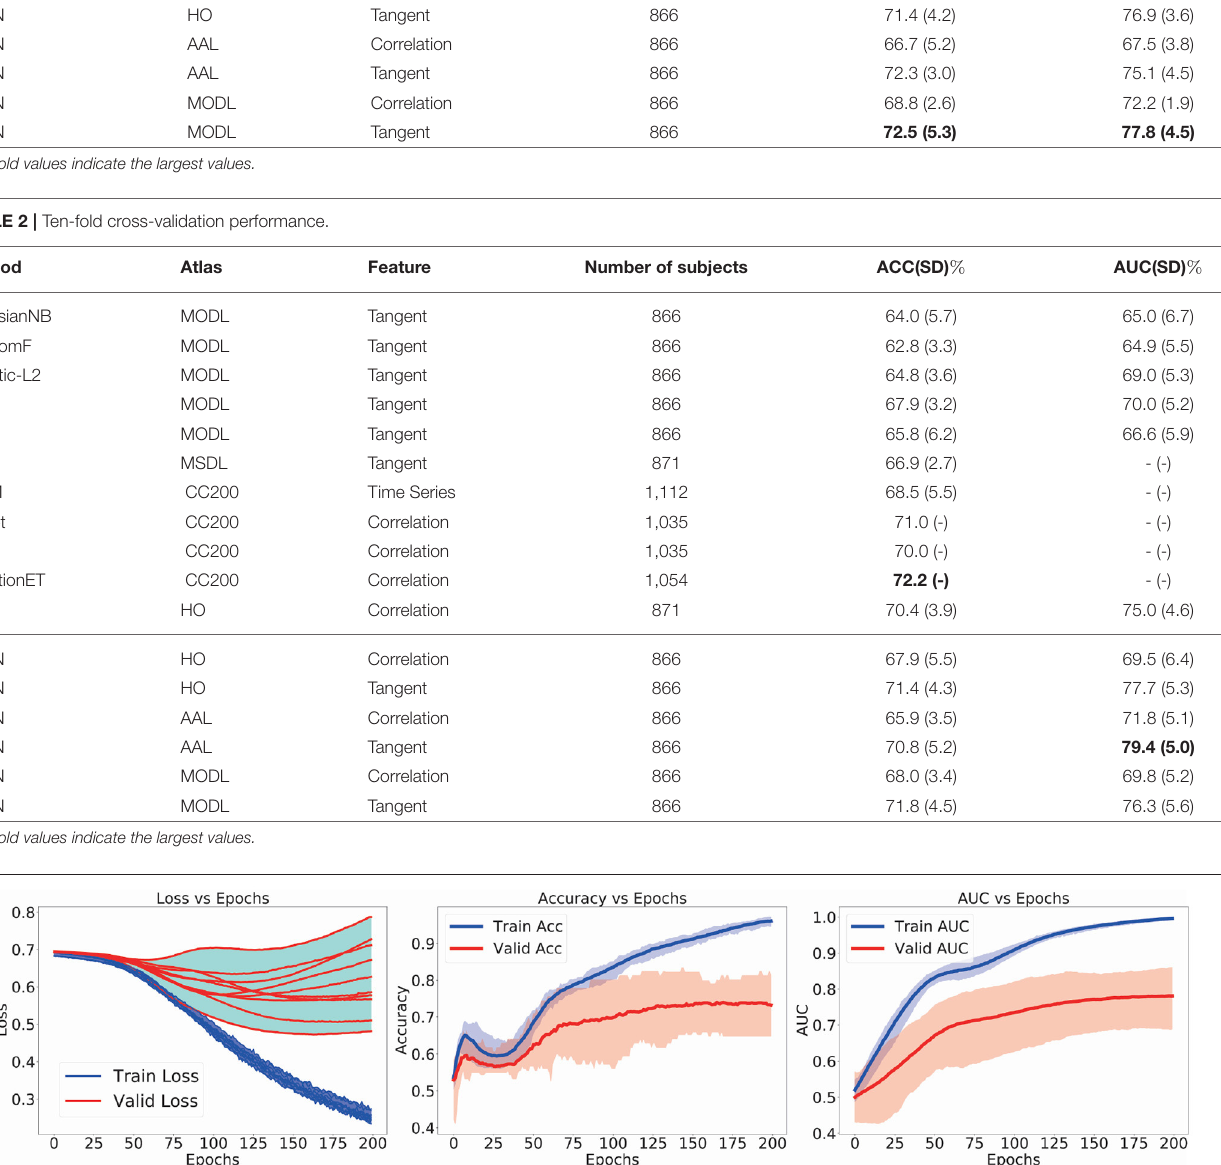
Frontiers in Neuroscience |